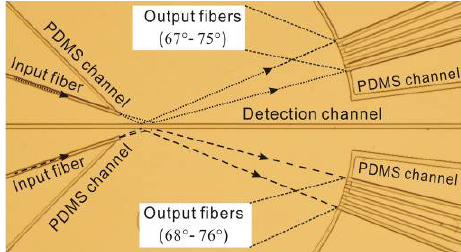
Fig. 1 Optical image of a microfluidic chip for multi-fiber RI sensing, which contains one detection channel, two input fibers channels, four PDMS channels, and ten output fiber channels. The dot and dash lines indicate the divergent incident light and reflected light, respectively.